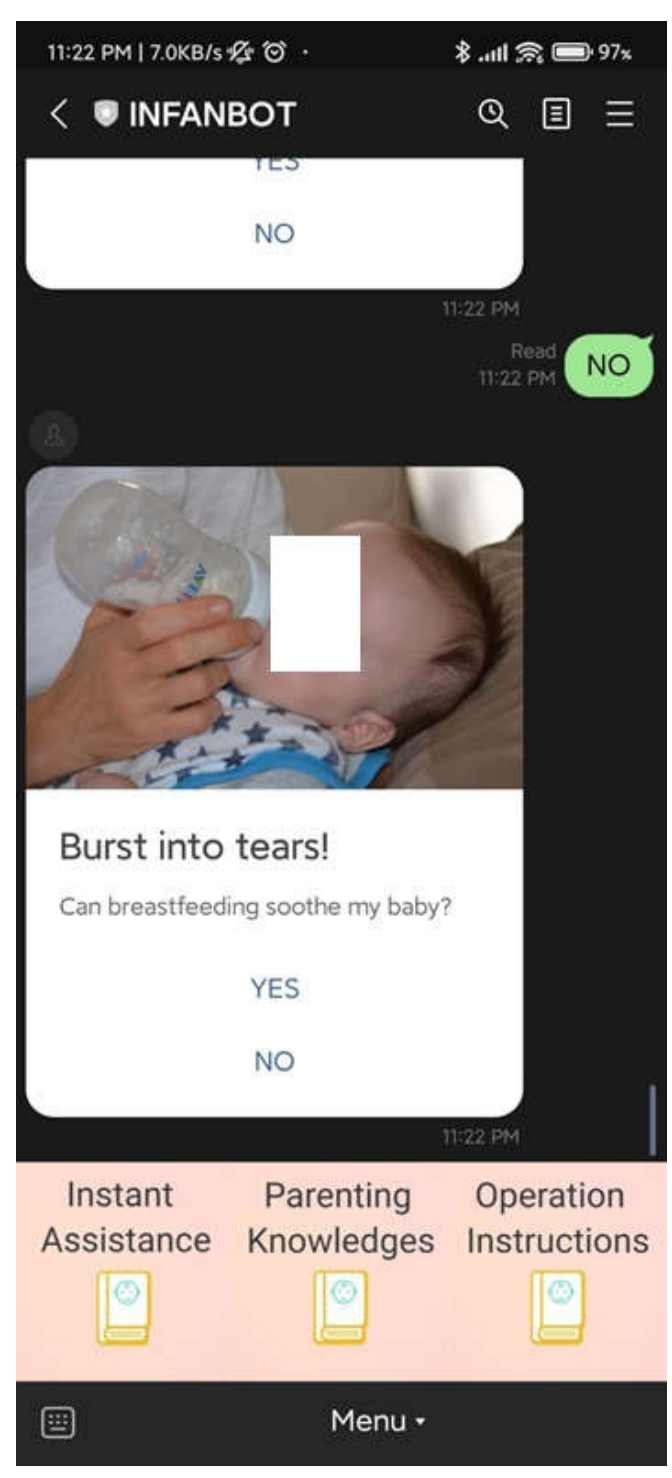
Figure 6. The relevant yes and no questions. (7) When receiving the “Parenting Knowledge” request from a user, the system will first query the database on whether the user is a new user or an old user. If they are a new user, the system will store the new user’s data on the User’s Data Sheet of the database and then send the “Parenting Knowledge menu” to the user. The user can scroll left and right to choose what they want, as shown in Figure